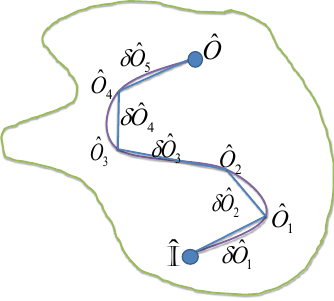
Figure 2 . A continuous curve c ( s ) connects the identity ( c (0) = ^ I ) and a particular operator ^ O ( c (1) = ^ O ). It can be approximated by a discrete form, where every intermediate point ( ^ O n ) is also an